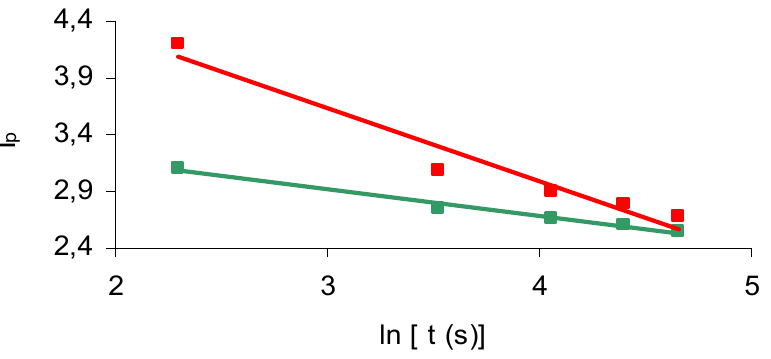
Figure 3. Linearized time-dependence of oxidation peak currents (I modified (green dots) and in the dsDNA-modified (red dots) glassy carbon